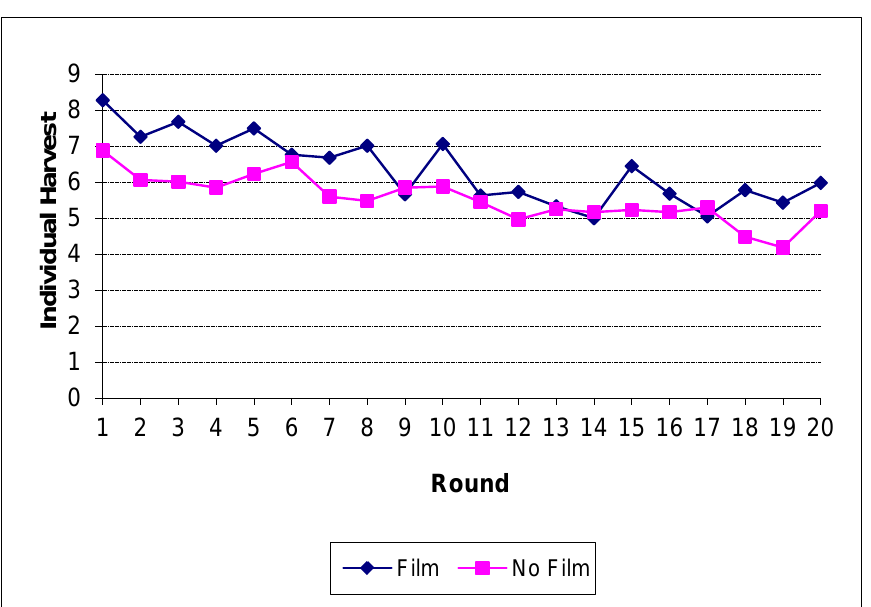
Figure 2. Comparing average individual harvests per round for villages with and without awareness film